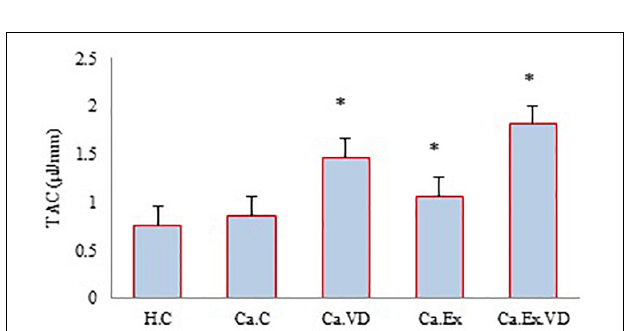
FIGURE 3 | The levels of total antioxidant capacity (TAC) during 6 weeks of interval exercise training (IET) and vitamin D supplementation treatment in all experimental groups. H.C, healthy control group; Ca.C, cancer control group; Ca.VD, cancer with injection of vitamin D group; Ca.Ex, cancer exercise training group, Ca.Ex.VD, cancer exercise training with injection of vitamin D group. Data are presented as mean ± SD. ∗ Significant level ( P ≤ 0.05).